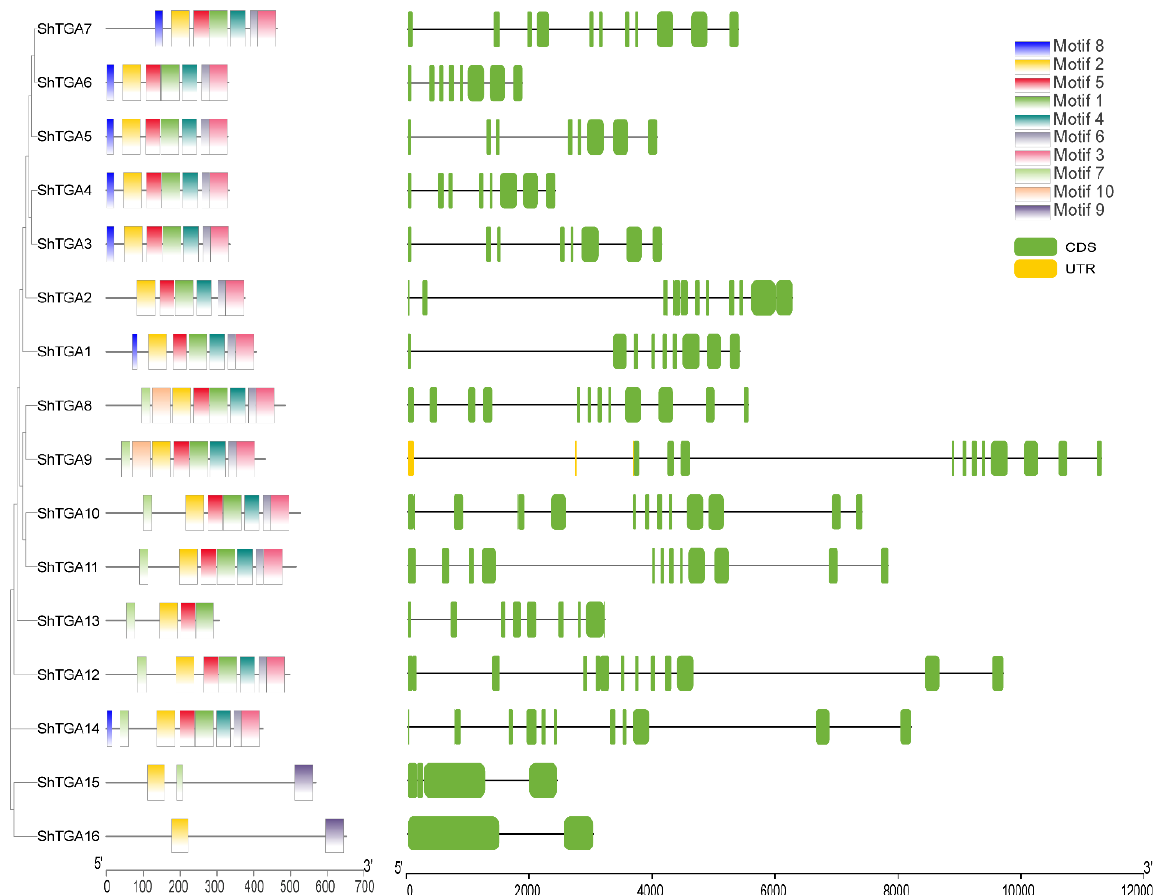
Figure 1. Analysis of conserved motifs and gene structure domains in all ShTGA family members. Phylogenetic tree was constructed using the ShTGA protein sequences. Ten types of conserved motifs were predicted, and different motifs are shown in different color boxes. The sequence information for each motif is provided in Supplementary Table S2. The gene structures of ShTGA members were visualized; coding sequence (CDS) and untranslated regions (UTR) are shown as light green boxes and yellow boxes, respectively.